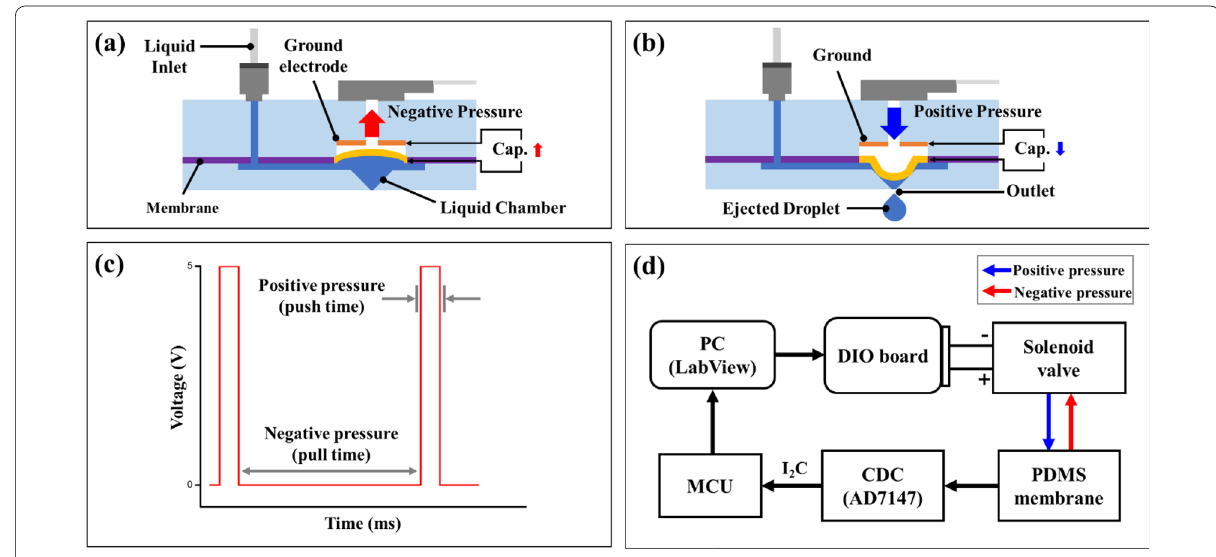
Fig. 3 Schematics of dispensing mechanism and signal processing; membrane deformation and droplet ejection process by a positive, b negative pressure, c a graph of the solenoid valve control signal, and d a diagram for measurement of control and sensor